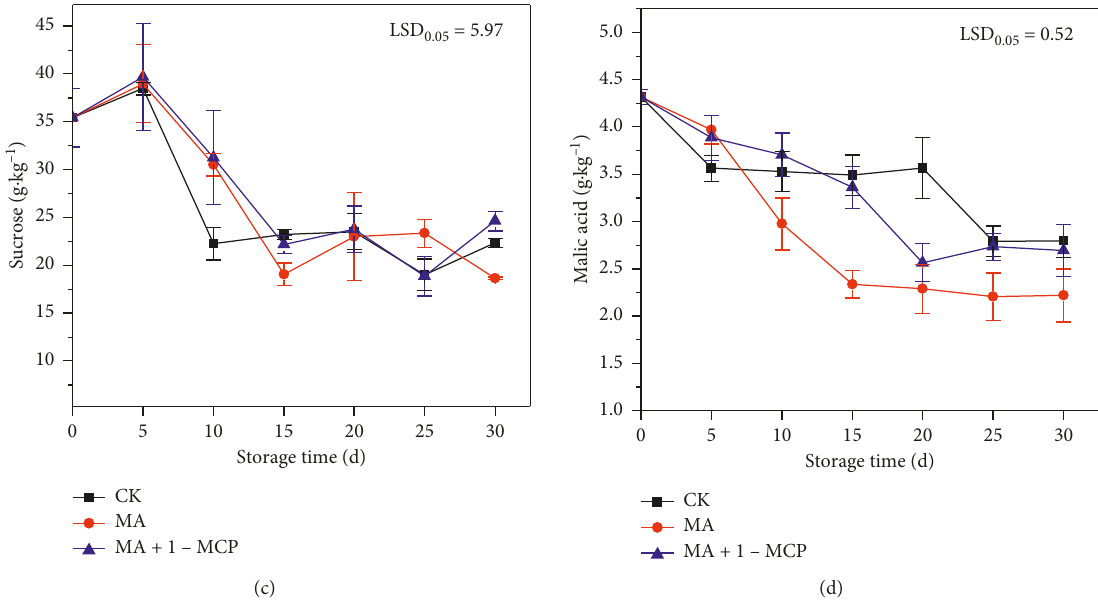
Figure 6: Effects of MA+1-MCP and MA treatment on the levels of fructose (a), glucose (b), sucrose (c), and malic acid (d) in fig fruit stored at − 1 ° C for 30 days. Data represent the mean value of five measurements ± the standard errors. LSDs represent significant differences at the 0.05